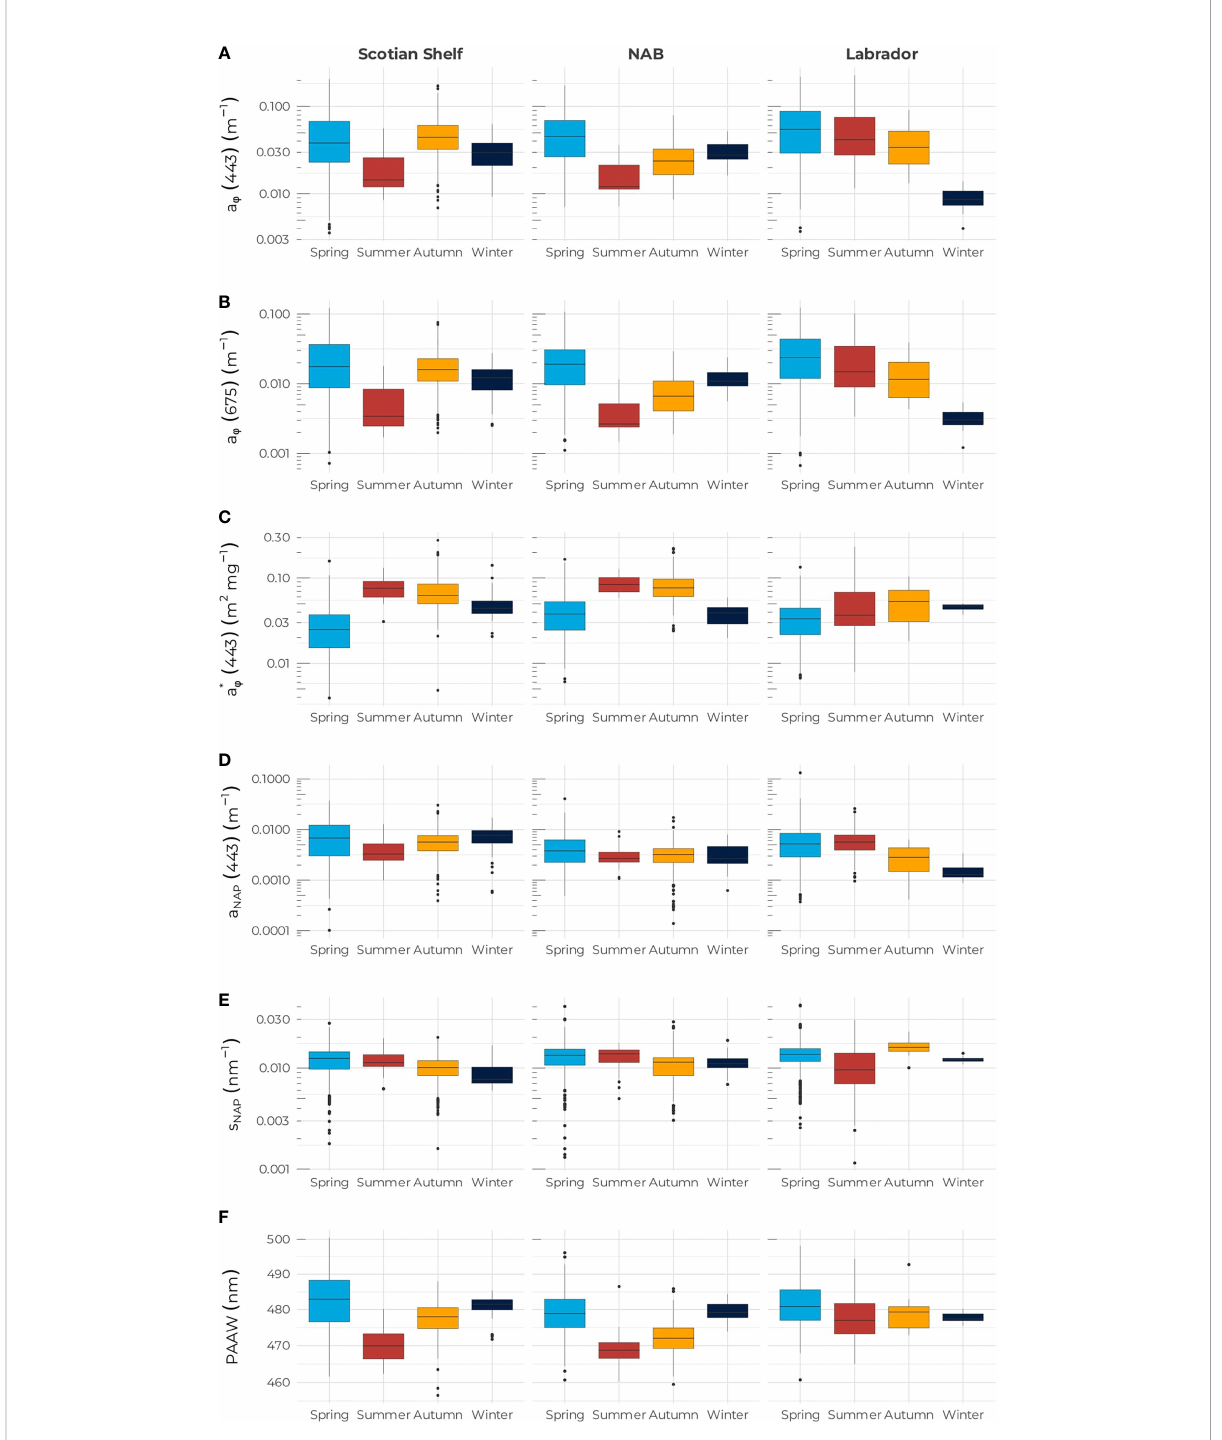
FIGURE 2 Mean and one standard deviation (i.e., boxplot) of (A) a f (443) (B) a f (675), (C) a ∗ f ð 443 Þ , (D) a NAP (443), (E) S NAP , and (F) PAAW for the Scotian Shelf (left column), Northwest Atlantic Basin (middle column), and Labrador Sea (right column). In each panel, the blue, red, yellow, and black boxes correspond to spring, summer, autumn, and winter,